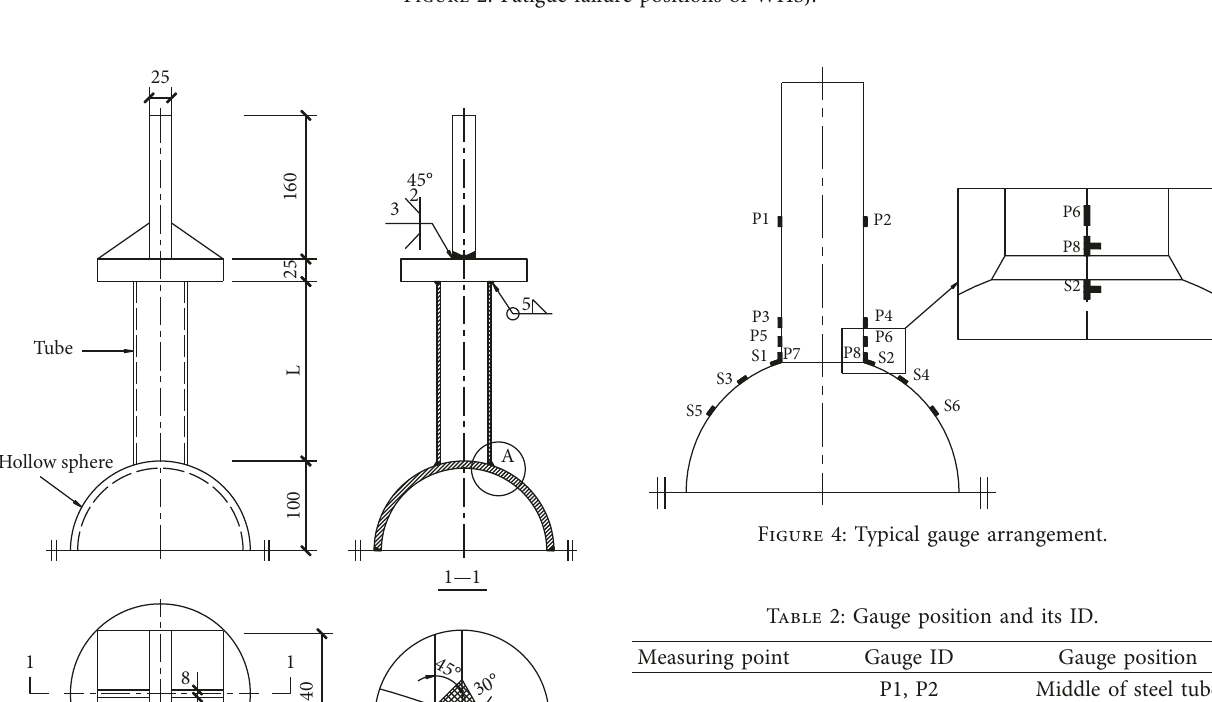
Figure 2: Fatigue failure positions of WHSJ.